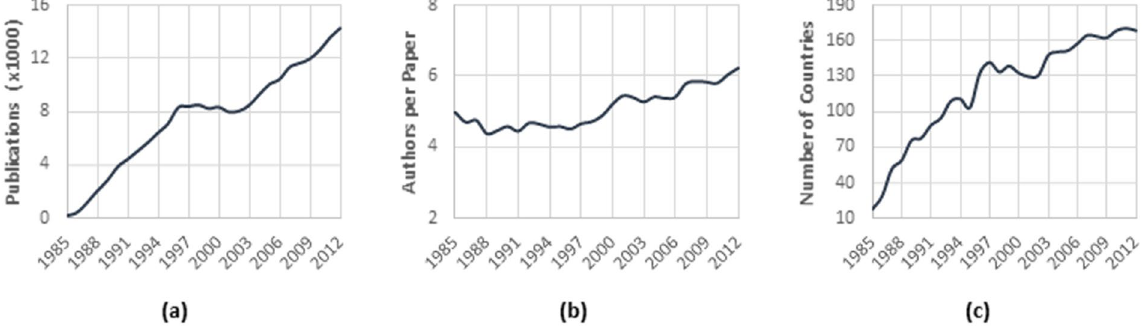
Figure 1. Trends in HIV/AIDS Publications: ( a ) global trend of publication; ( b ) average number of authors per paper; ( c ) number of countries contributing to HIV/AIDS research.